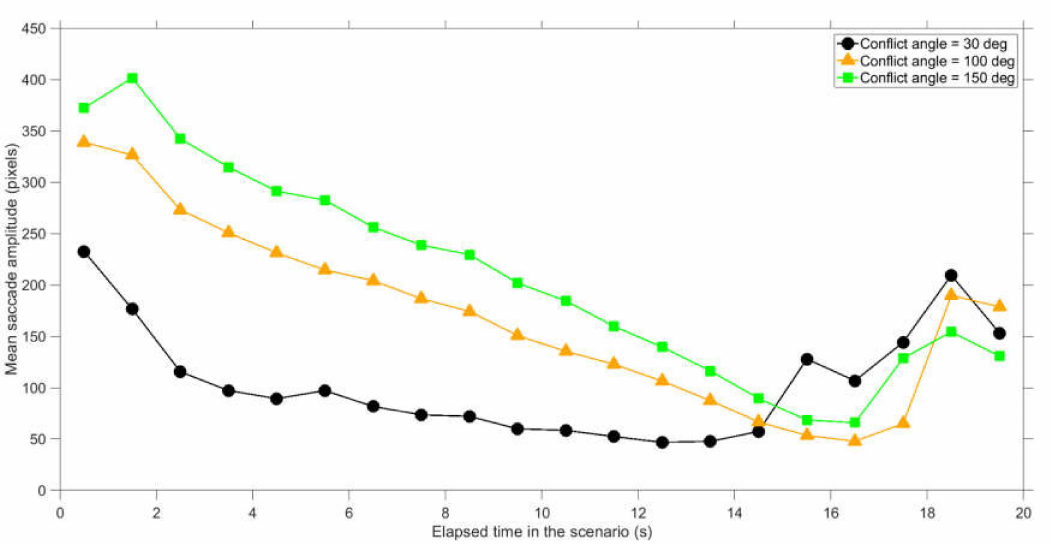
Figure 10. Mean saccade amplitude per conflict angle, where the end moments of saccades are divided into 1 s bins since the start of the scenario. The shown values represent averages for 35 participants and 12 scenarios per participant (conflict scenarios and non-conflict scenarios combined).